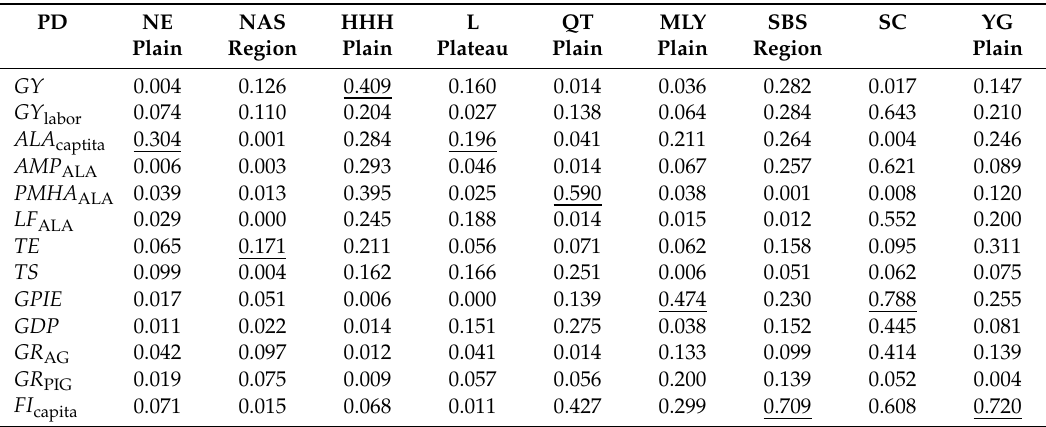
Table 5. The PD values as derived from the Geo-Detector for the influence of thirteen factors on cropping intensity changes. The maximum PD values for each region are